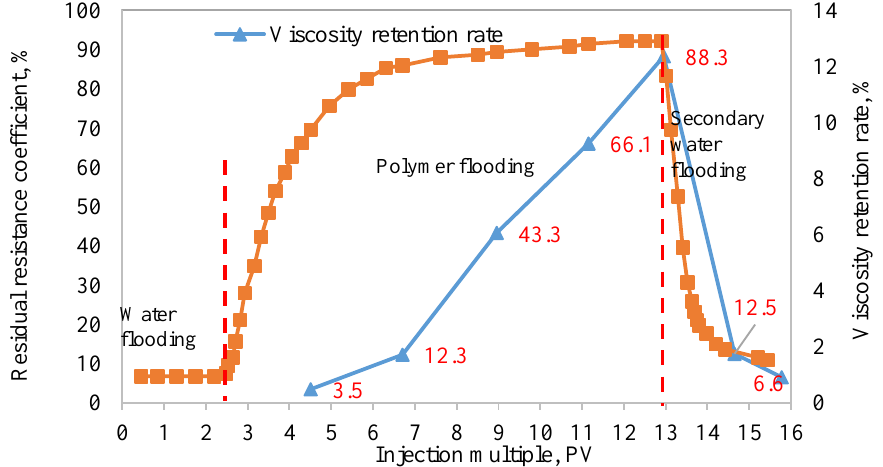
Figure 4—Injection experiment of hydrophobic associating